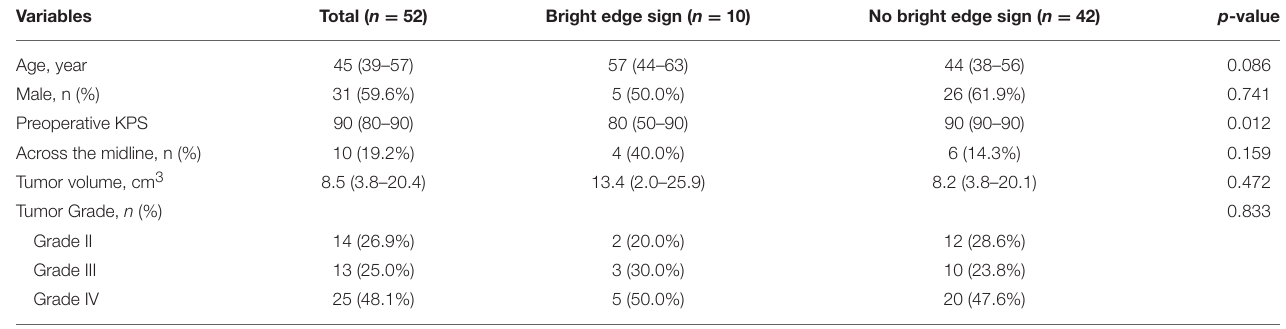
TABLE 1 | Baseline characteristics of patients.